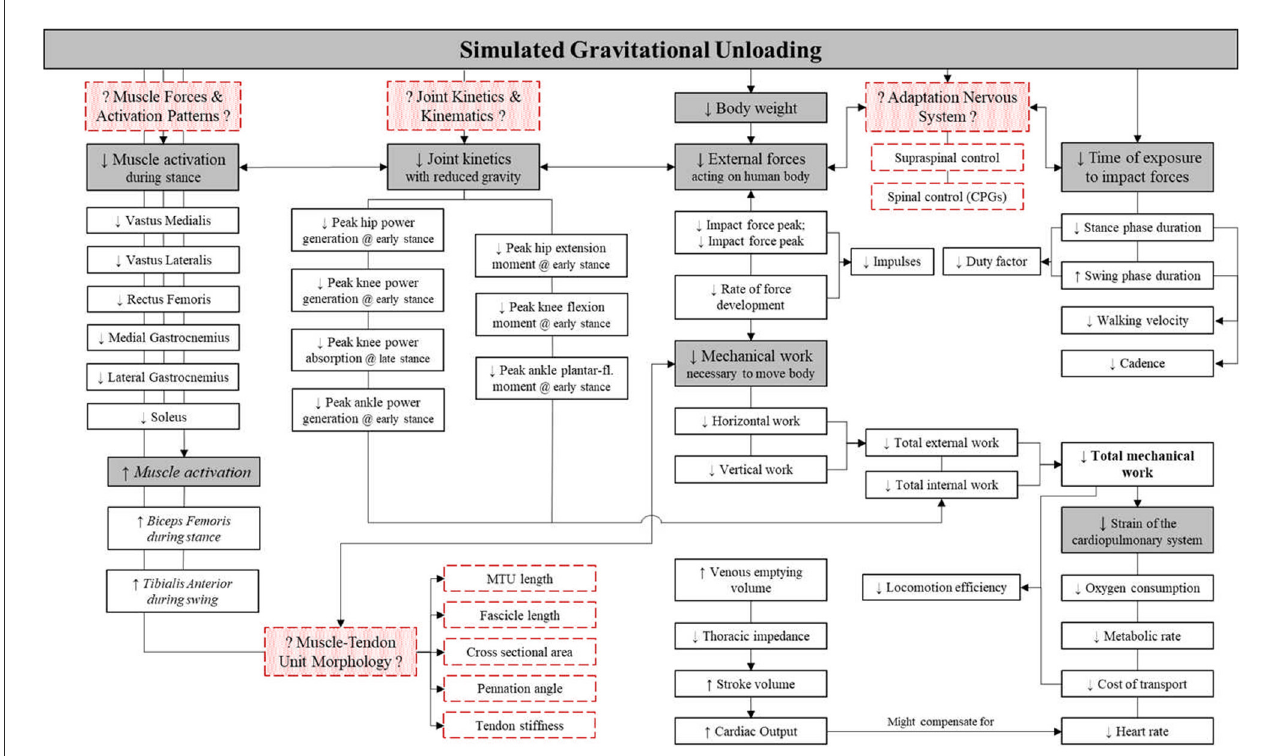
FIGURE2 Schematic of the apparent effect of body weight support (BWS) upon lower limb muscle activation, whole body kinetics and kinematics and cardiorespiratory outcomes. Red boxes with dashed outline represent gaps in current knowledge to be filled. Gray boxes represent main physiological factors, with white boxes representing the underlying outcome parameters. Italics, trends; ↓ , decrease; ↑ , increase; CPG, central pattern generator; MTU, muscle-tendon unit. Figure adapted from Richter et al.